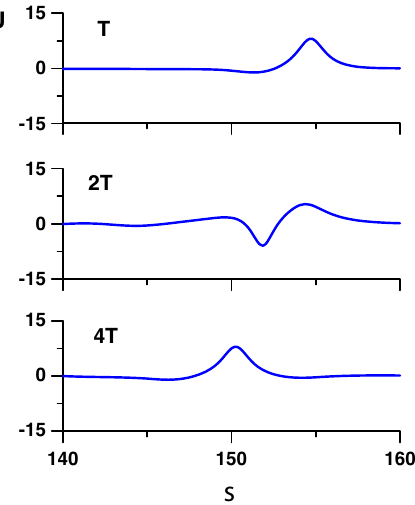
Fig. 5. Numerical simulation of the evKdV equation (6) for the case when δ = 1, β = 0 . 3, ν = 0 and α varies from 1 to − 1. The initial wave (not shown) is a solitary wave of elevation belonging to the branch for which B > 0. It then passes adiabatically through the critical point, changing the sign of B to B < 0, and arrives at the location α = − 1 where ξ = T with only a small deformation. However, at this stage its amplitude is below that allowed for a steady solitary wave, and so it deforms into a breather, shown in the middle panel for ξ = 2 T and the lower panel for ξ = 4 T